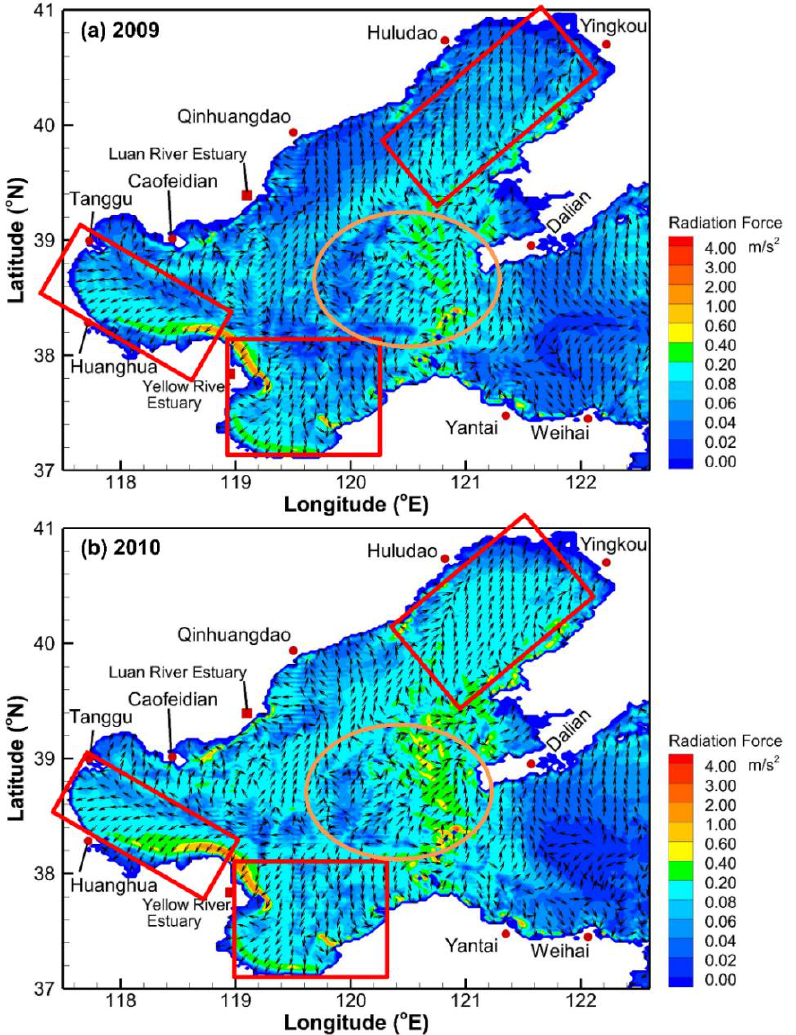
Figure 9. Wave force distributions in the Bohai Bay during the 2009 ( a ) and 2010 ( b ) storms (at the time step for which the surge in the south Bohai Sea peaks). The red rectangles represent the regions with a unidirectional wave force and the orange circles represent the regions with a non-uniform wave force.